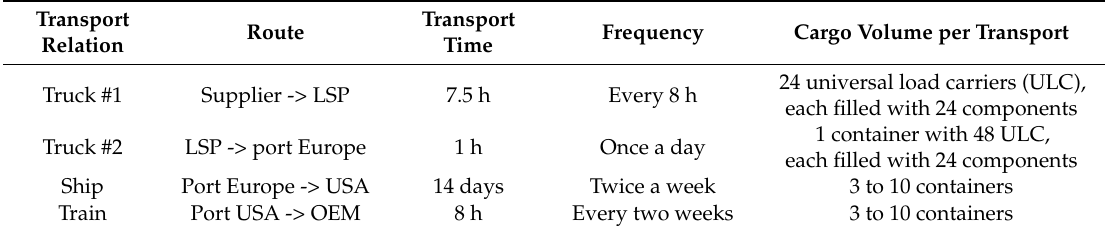
Table 3. Transport relations in the simulation